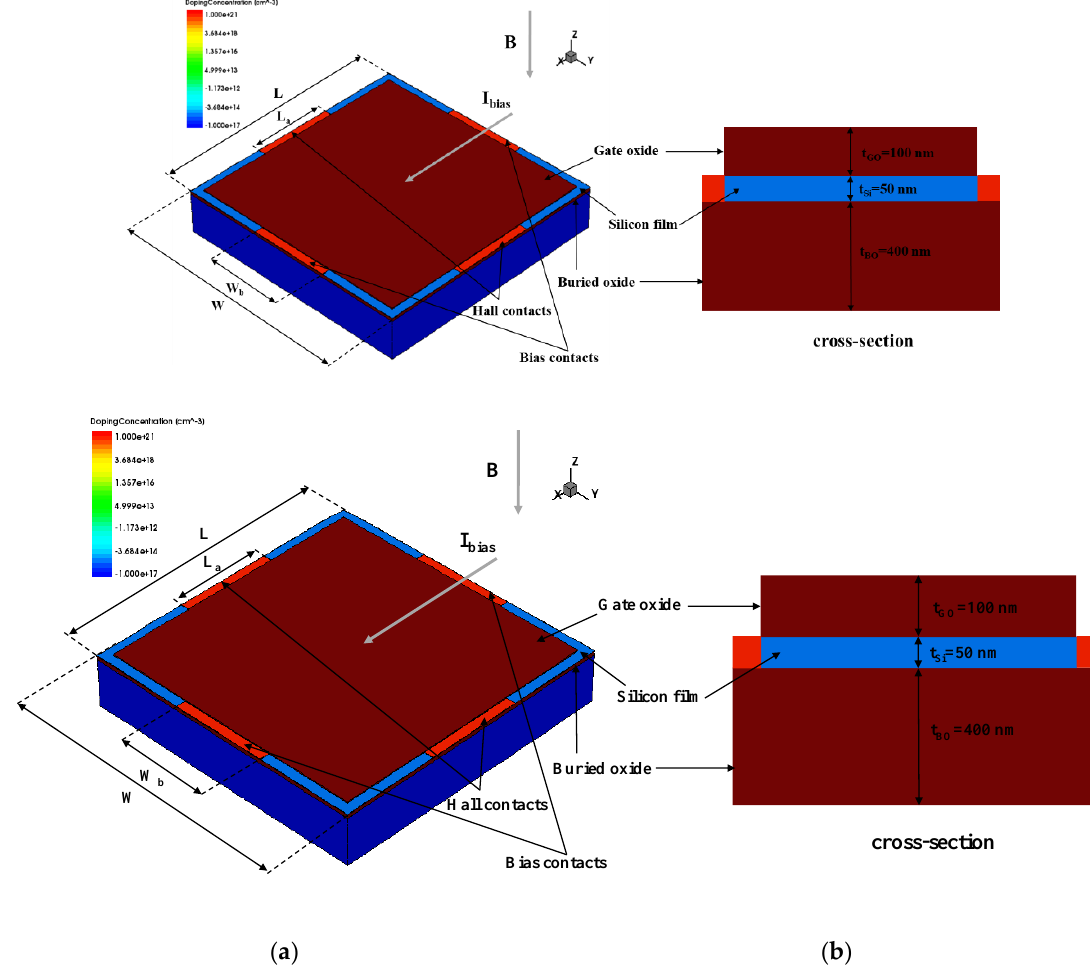
Figure 1. ( a ) 3D geometric model and ( b ) cross-section of the FD-SOI Hall sensor.